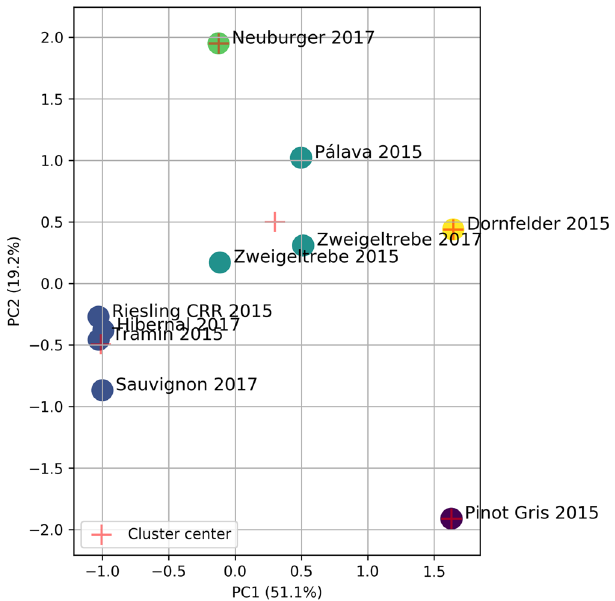
Figure 1. k-Means clusters for standardized PCs in analysis for fatty acid profile.